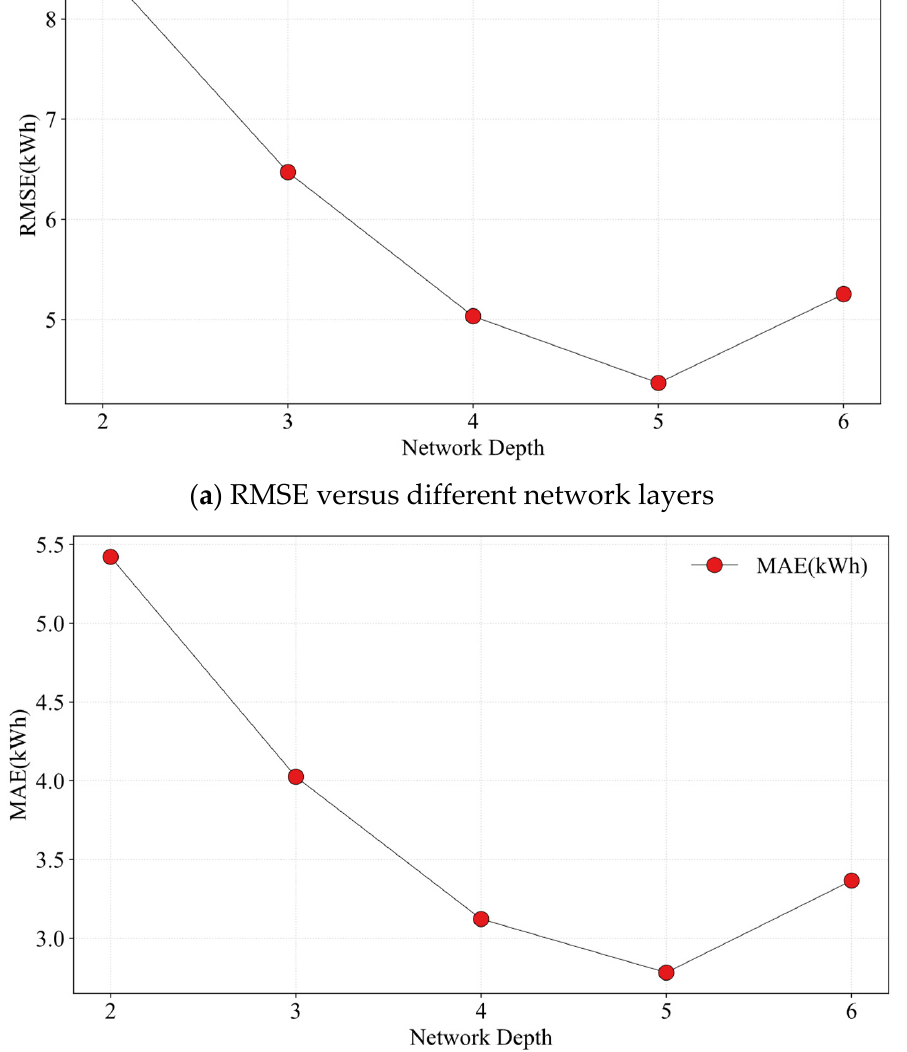
Figure 8. The result of RMSE ( a ) and MAE ( b ) for the LSTM-BDL model with the changes in the network depth.